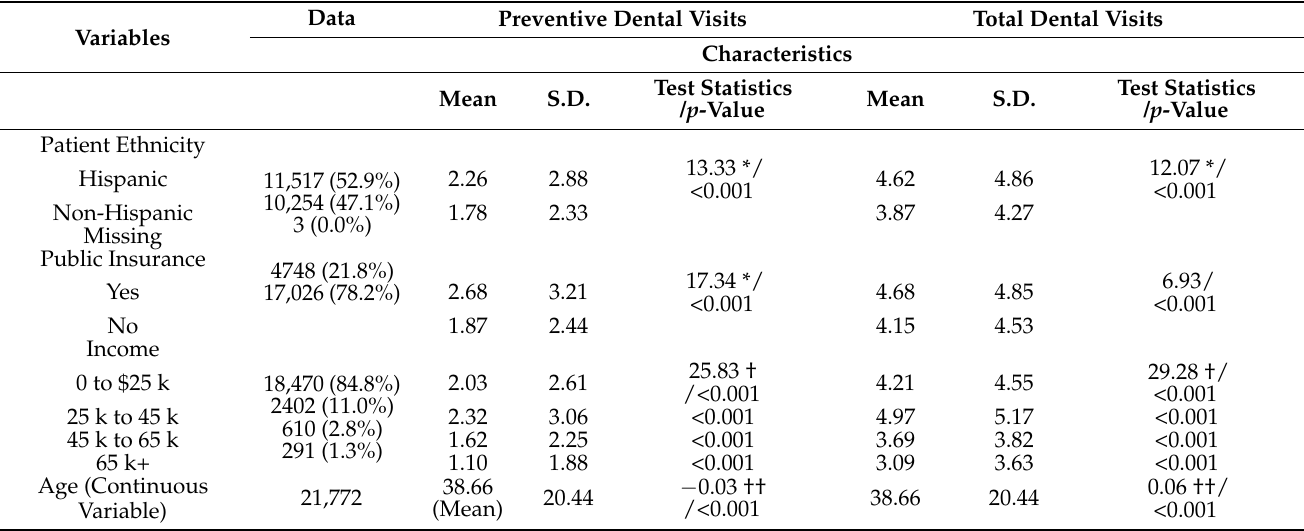
Figure 1. The Kernel Density Curve for Age. Table 1. Sociodemographic and Dental Visit Information for Patients Visiting the Dental Clinic from January 2016 to January 2022.